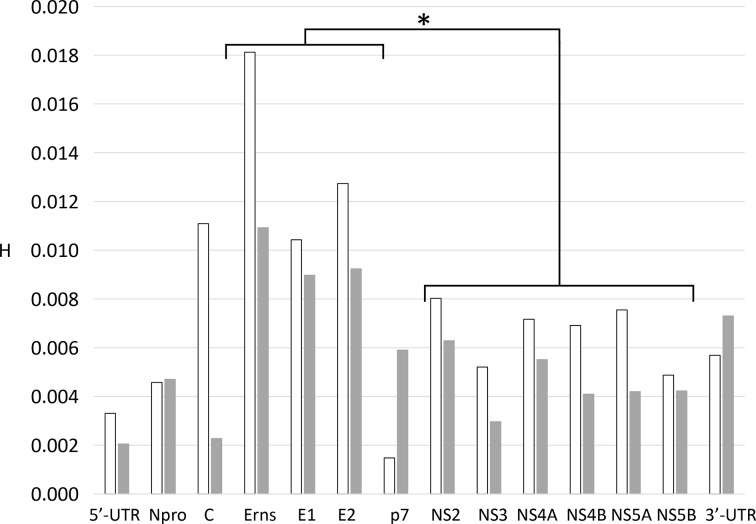
Distribution of sequence variation across the MRI103 genome. For each gene, the mean single-nucleotide entropy (H) was plotted. The columns are shaded as for Fig. 1: white, MRI103-serum; light grey, MRI103-culture. Student’s t-test comparison of the glycoprotein-encoding genes (Erns, E1, E2) and the non-structural genes (NS2–NS5B) showed that mean entropy among the glycoprotein-encoding genes was significantly higher than for the NS genes for both the serum and the cultured virus (P<0.01), indicated by an asterisk.